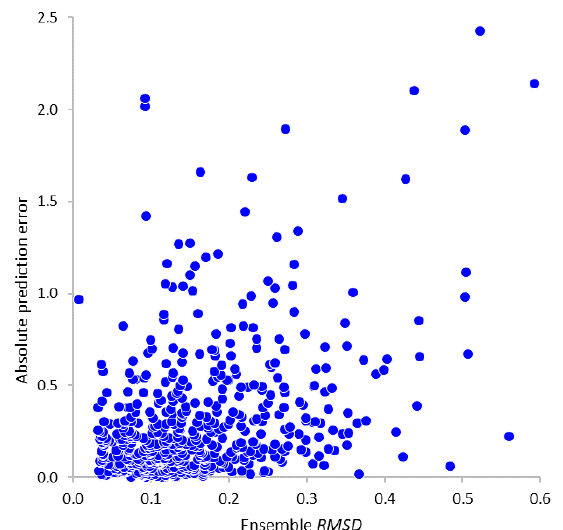
Figure 6. Correlation between the ensemble standard deviations of predicted LogBB values and the resulting absolute prediction errors for the external validation dataset compounds.